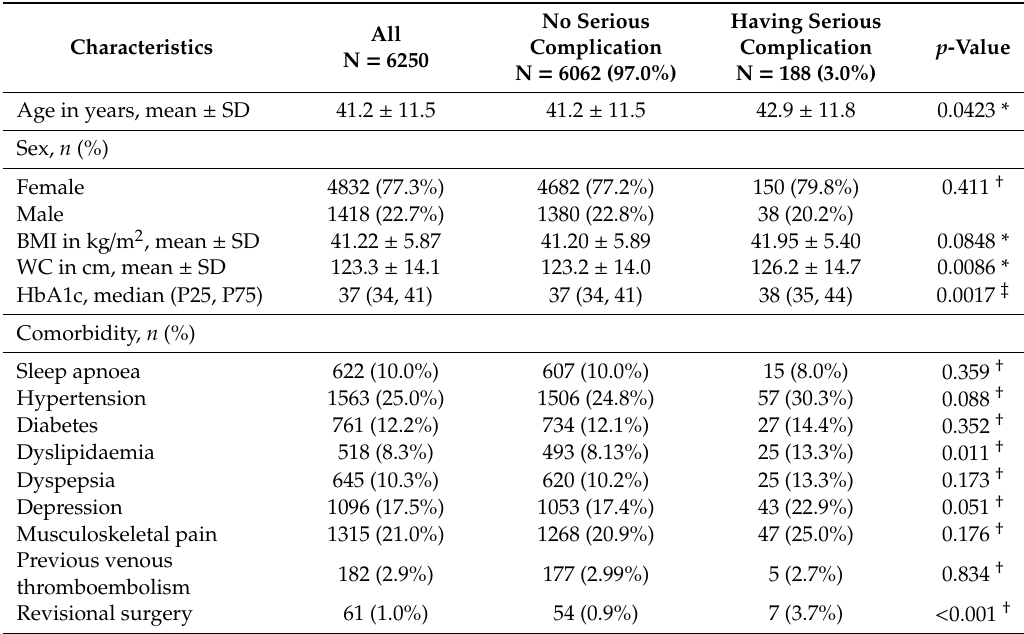
Table 2. Base line characteristics of the test